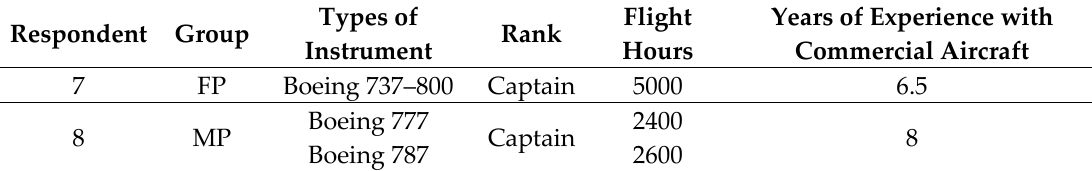
Table 2. The background information of FP and MP